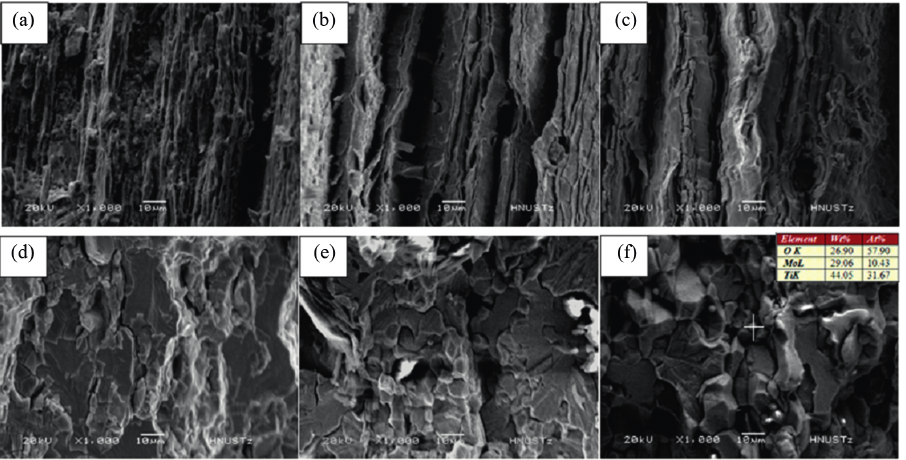
Figure 8: Tensile fracture topography of Mo-0.5Ti alloy after different temperatures of annealing (a) unannealing (b) 800°C (c) 1,000°C